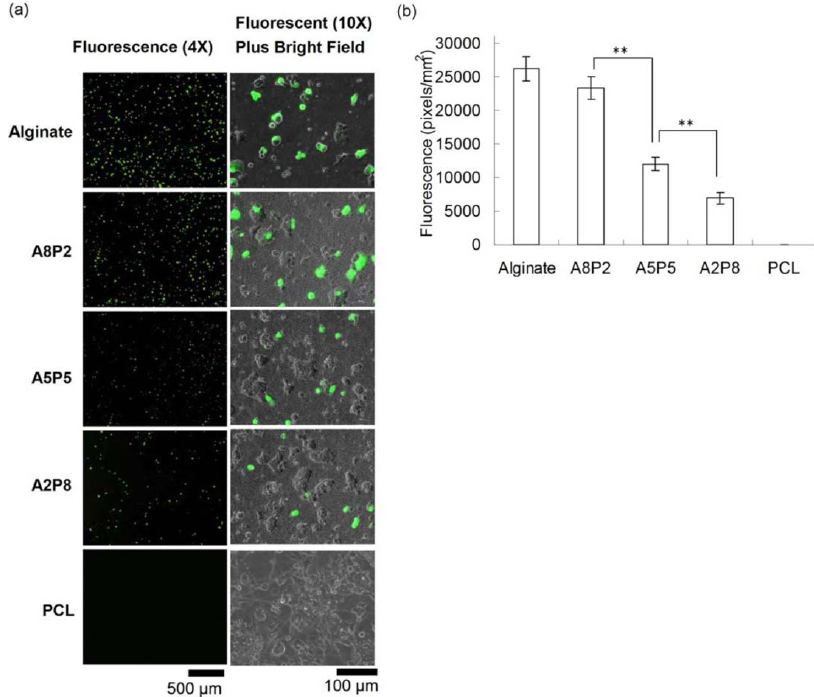
Figure 6. In situ transfection on nanofibers. ( a ) After immobilizing DNA / polyethyleneimine (PEI) nanoparticles, HEK-293T cells were seeded on nanofibers and cultured for 3 days, and the GFP expression from transfected cells was evaluated using fluorescent microscopy. The results suggested the transfection e ffi ciency of composites fibers increased with their alginate ratios. ( b ) The quantification of GFP from fluorescent images also showed the same trend (where, 80% alginate / 20% polycaprolactone (PCL), 50% alginate / 50% PCL, and 20% alginate / 80% PCL, which were denoted as A8P2, A5P5, and A2P8, respectively). Reprinted with permission from